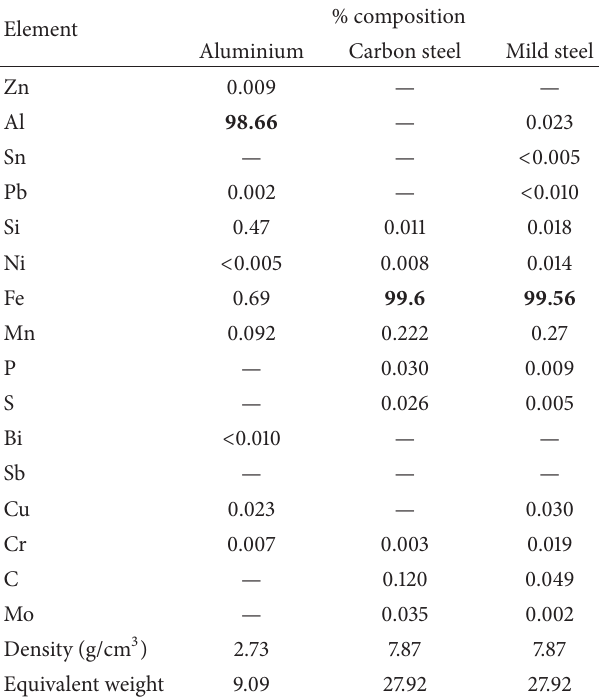
Table 1: Composition, density, and equivalent weight of the materi-